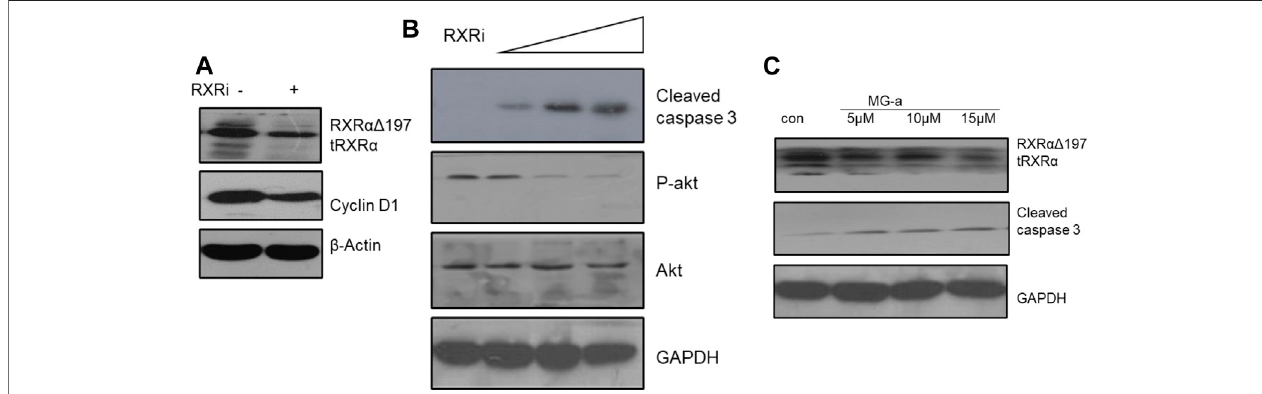
FIGURE 4 | α -Mangostin induces the degradation of RXR α /tRXR and inhibits Akt activity in MDA-MB-231 cells. (A,B) The expression levels ofcyclinD1 and P-Akt were determined by western blotting analysis in MDA-MB-231 cells after knockdown of RXR α . (C) The expression levels of RXR α /tRXR and cleaved caspase-3 were determined by western blotting analysis in MDA-MB-231 cells after α -Mangostin